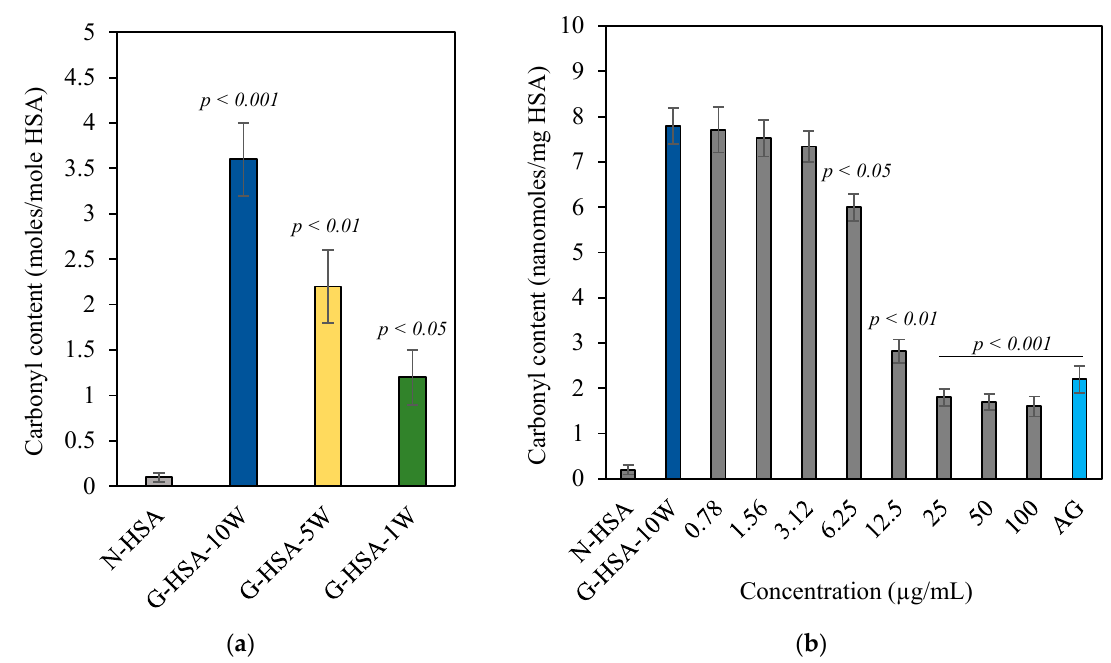
Figure 3. Formation of protein bound carbonyl content in the non-glycated and glycated samples of HSA ( a ). Effect of garlic extract on the formation of protein bound carbonyl content in the process of HSA glycation (10 weeks) with different concentrations (0.78–100 µg/mL) ( b ). All the reactions were carried out under similar experimental conditions. Data is presented as mean ± SD values. t test was adopted for comparison between non-glycated and glycated samples of HSA, and significance was calculated.